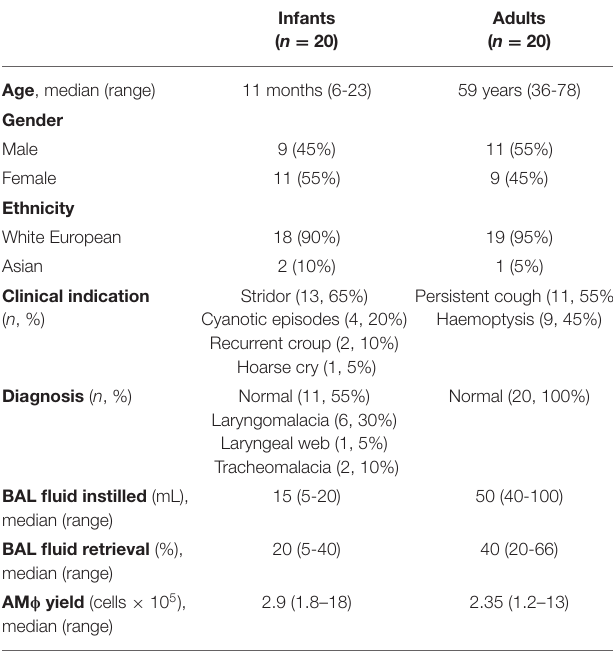
TABLE 1 | Baseline characteristics and macrophage yield of